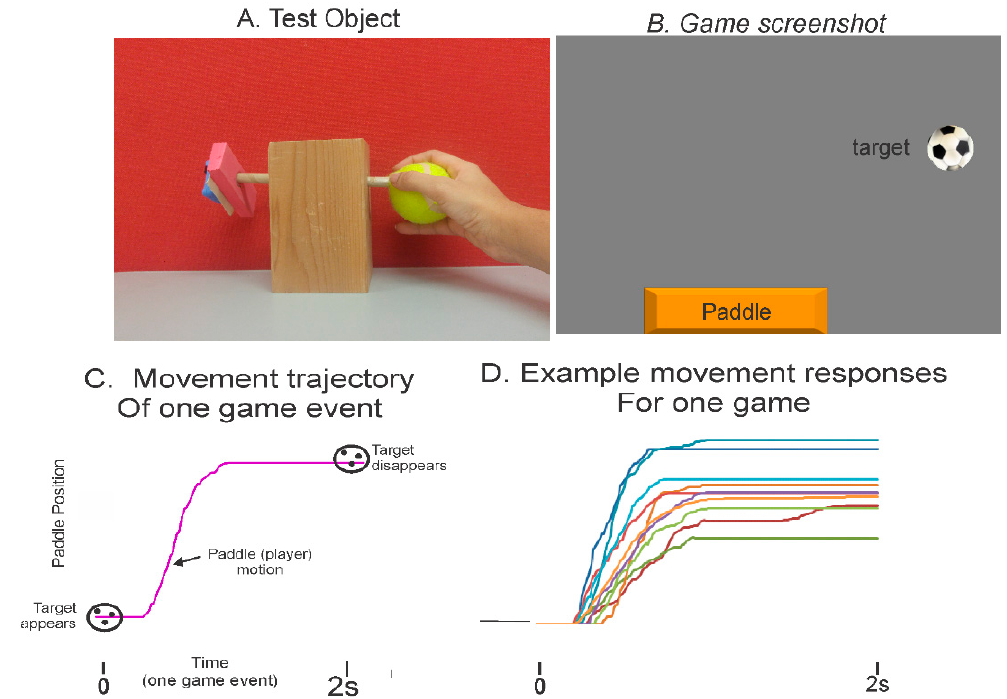
Figure 3. Assessment illustrations using the motor skill game (MSG) module. ( A ) A simple crafted object with motion mouse attached to the left end of wooden dowel by velcro. As seen, finger pinch grip is used to rotate the dowel. ( B ) A screenshot of game showing target object (computer controlled) and game paddle (slaved to rotation of the tennis ball using the motion mouse). ( C ) Trajectory of game paddle of one typical game event from target appearance (time zero) to target disappearance (time 2 s). ( D ) Overlay plots of the segmented and sorted game movement trajectories for a 60 s game trial.